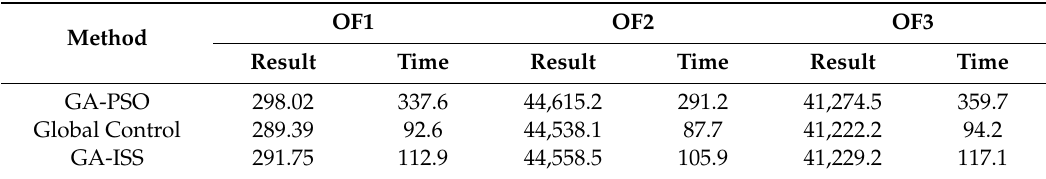
Table 7. Outcomes of di ff erent solving